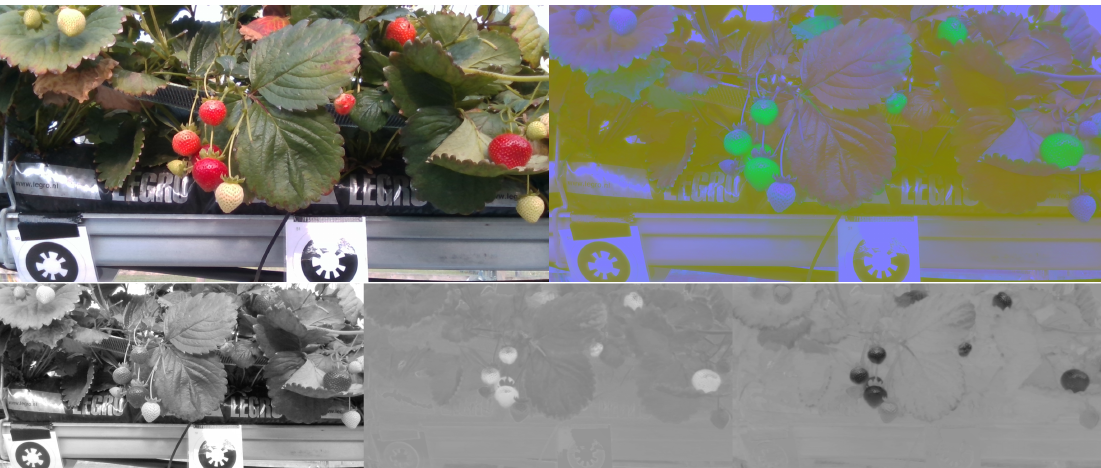
Figure 3. Network Input: Visualisation of RGB ( top left ) and CIELab ( top right ) used in model training. It’s evident in the opponent feature channels ( bottom row ) of CIELab that this colour space is appropriate for fruit detection due to the maximal and minimal response of fruit pixels.